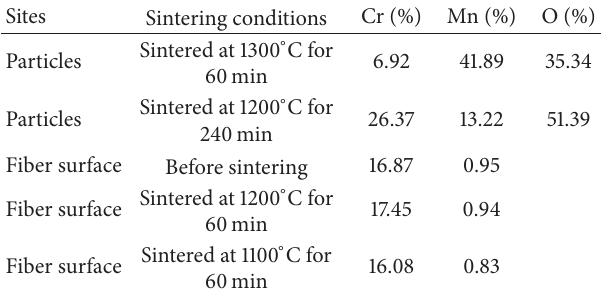
Table 1: Mn, Cr, and O contents of stainless steel fiber surface and